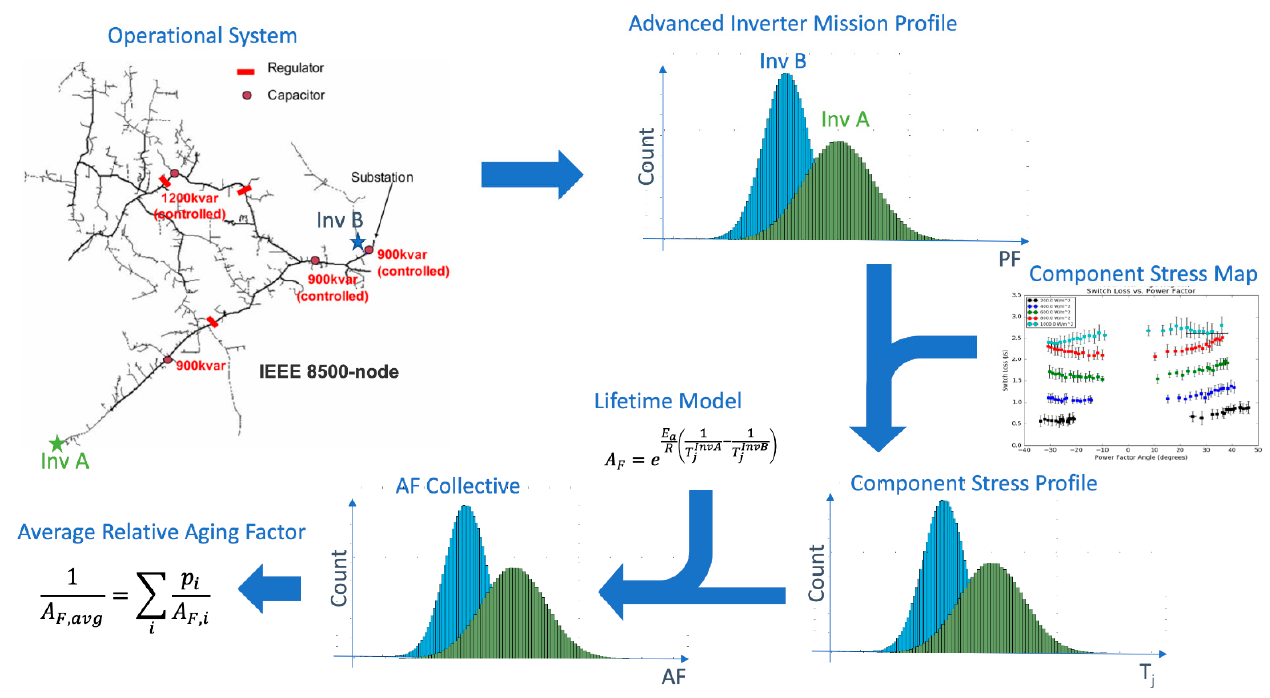
Figure 11. Framework for determination of average inverter acceleration factor. An inverter in a system has a given profile of advanced inverter functionality. This profile can be paired with a component loss map determined experimentally to derive an ensemble of component stress over the profile period. This stress can be translated into a collective of acceleration factors and an average acceleration factor can be derived.